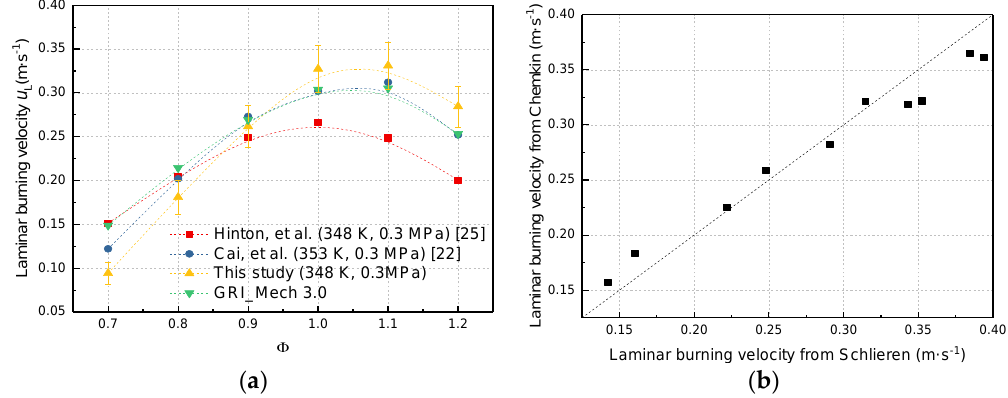
Figure 3. Validation of present experimental and simulation studies. ( a ) Comparing with previous data; ( b ) Comparing Chemkin with Schlieren.